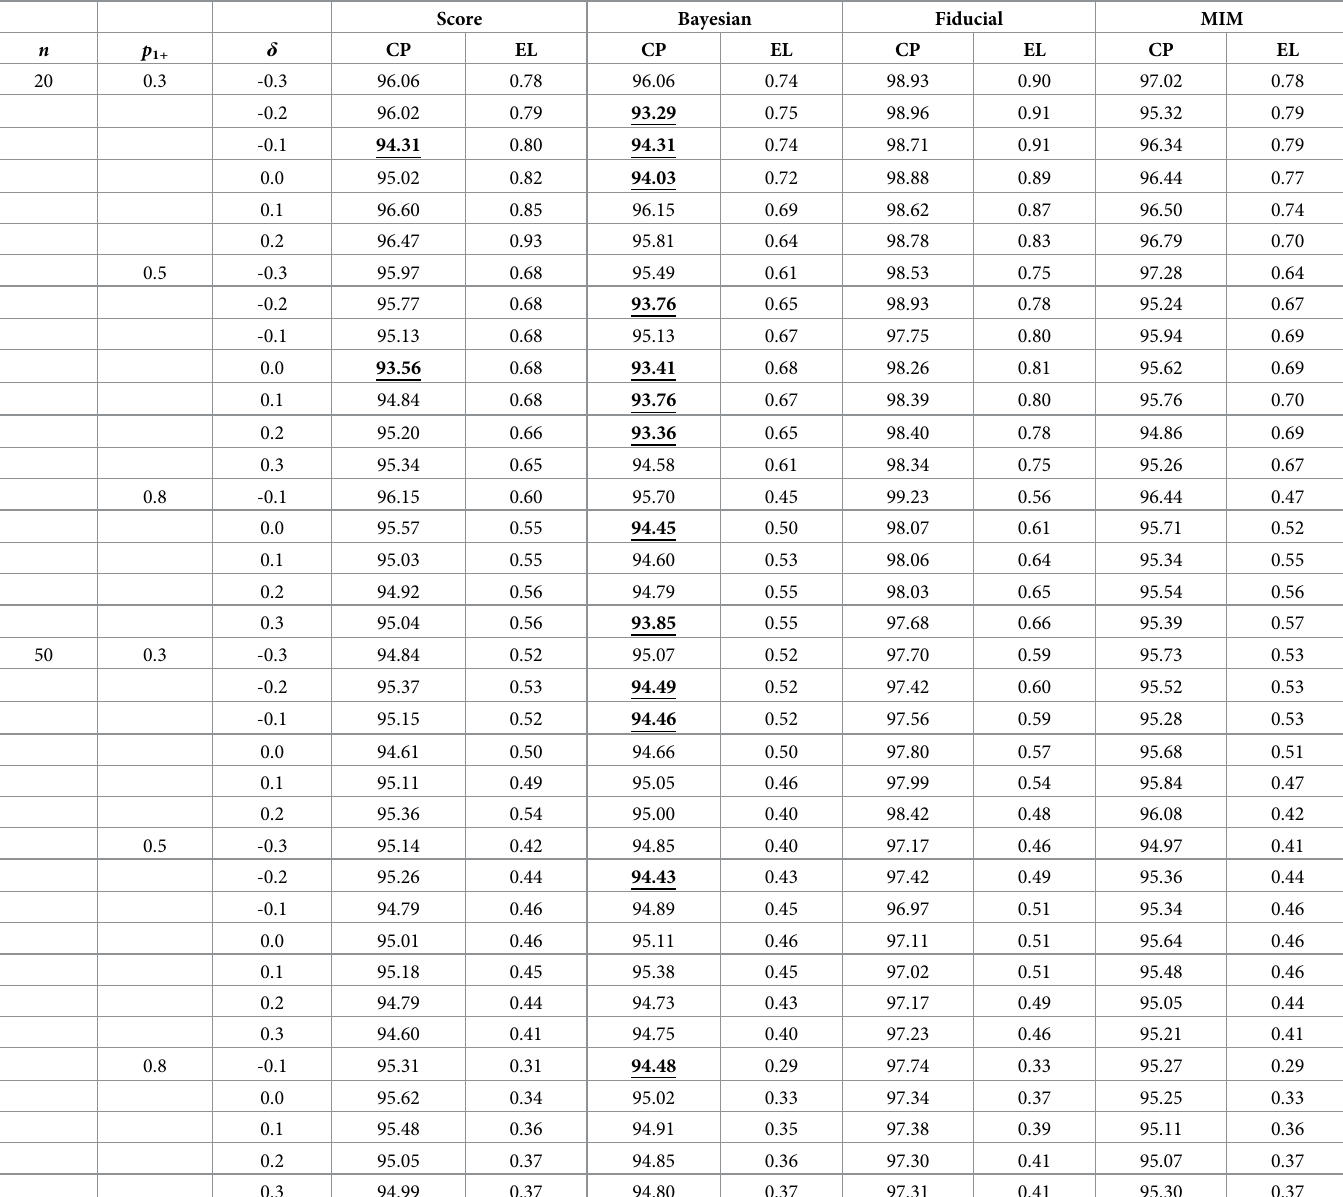
Table 3. The coverage probability (CP) and the expected length (EL) of various 95%